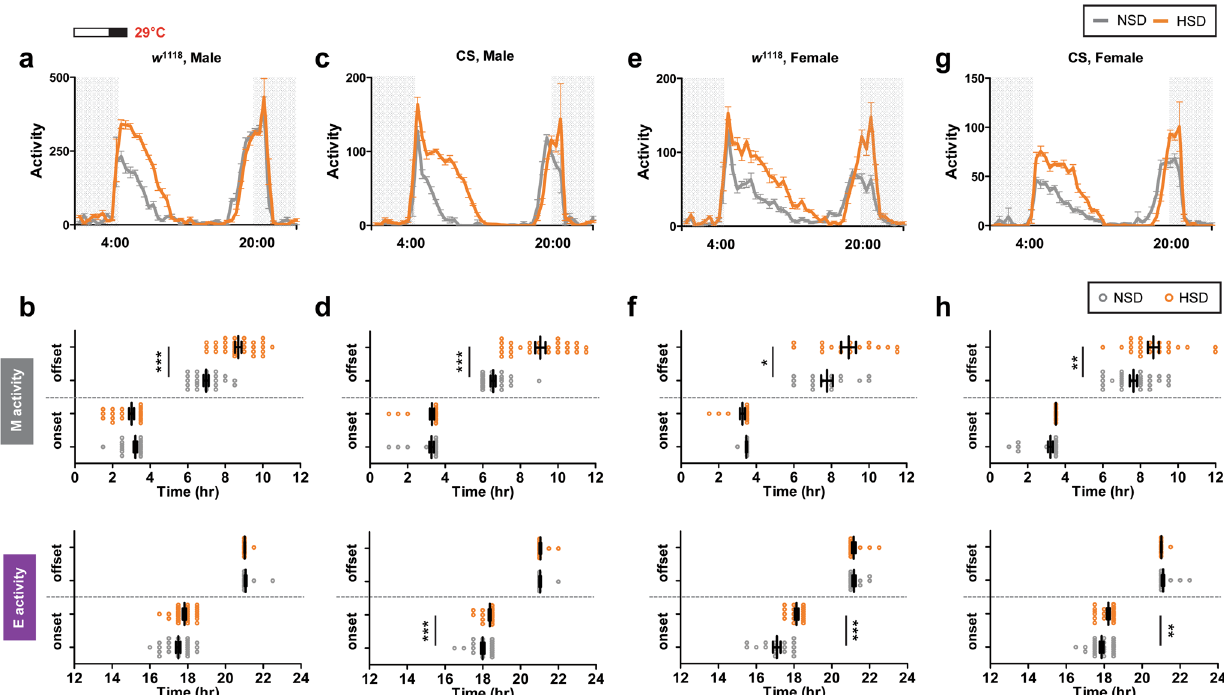
Fig. 2 The effect of a HSD on M activity offset was observed in other genotypes of control fl ies and in females. a , c , e , g Locomotor activities of w 1118 male ( a ) and female ( e ), Canton S (CS) male ( c ), and female ( g ) fl ies locomotor activities were analyzed in NSD and HSD conditions under a 16L:8D cycle at 29 °C. Daily activity pro fi les of given genotypes of fl ies (denoted on top) on day 7 are shown. b , d , f , h M and E activity onset/offset of w 1118 male ( b ), w 1118 female ( f ), CS male ( d ), and CS female ( h ) fl ies on day 7 are plotted. Bars indicate mean ± SEM ( n = 15 – 32). Statistically signi fi cant differences in the onset or offset between NSD and HSD conditions (independent t test): * P < 0.05, ** P < 0.01, *** P <